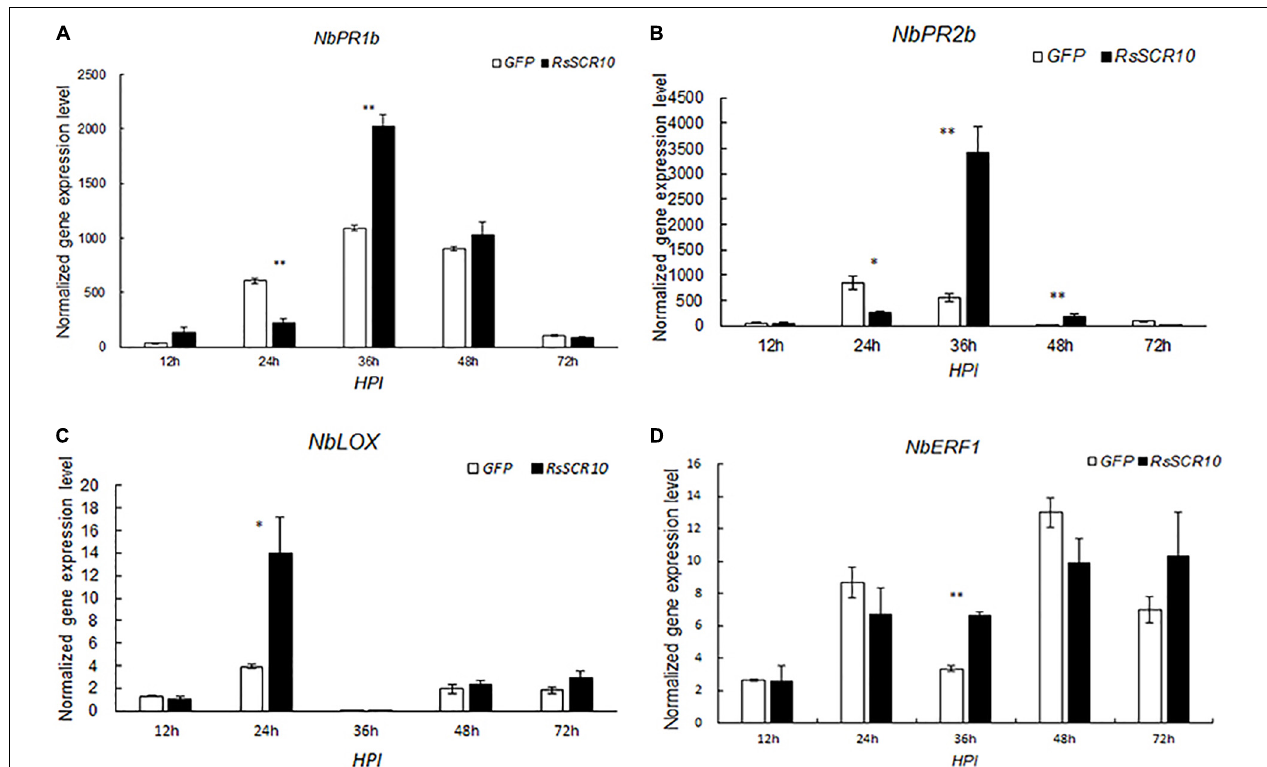
FIGURE 3 | Expression patterns of host defense genes after agroinfiltration of RsSCR10. Transcript levels of the genes (A) NbPR1b, (B) NbPR2b , (C) NbLOX , and (D) NbERF1 , induced by RsSCR10 at different time points. NbPR1b and NbPR2b are key genes of the salicylic acid pathway, NbLOX is a key gene of the jasmonic acid pathway, and NbERF1 is a key gene of the ethylene pathway. Error bars represent standard errors from three biological replicates. Asterisks indicate statistical significance (Student’s t -test) at *5% level and **1%